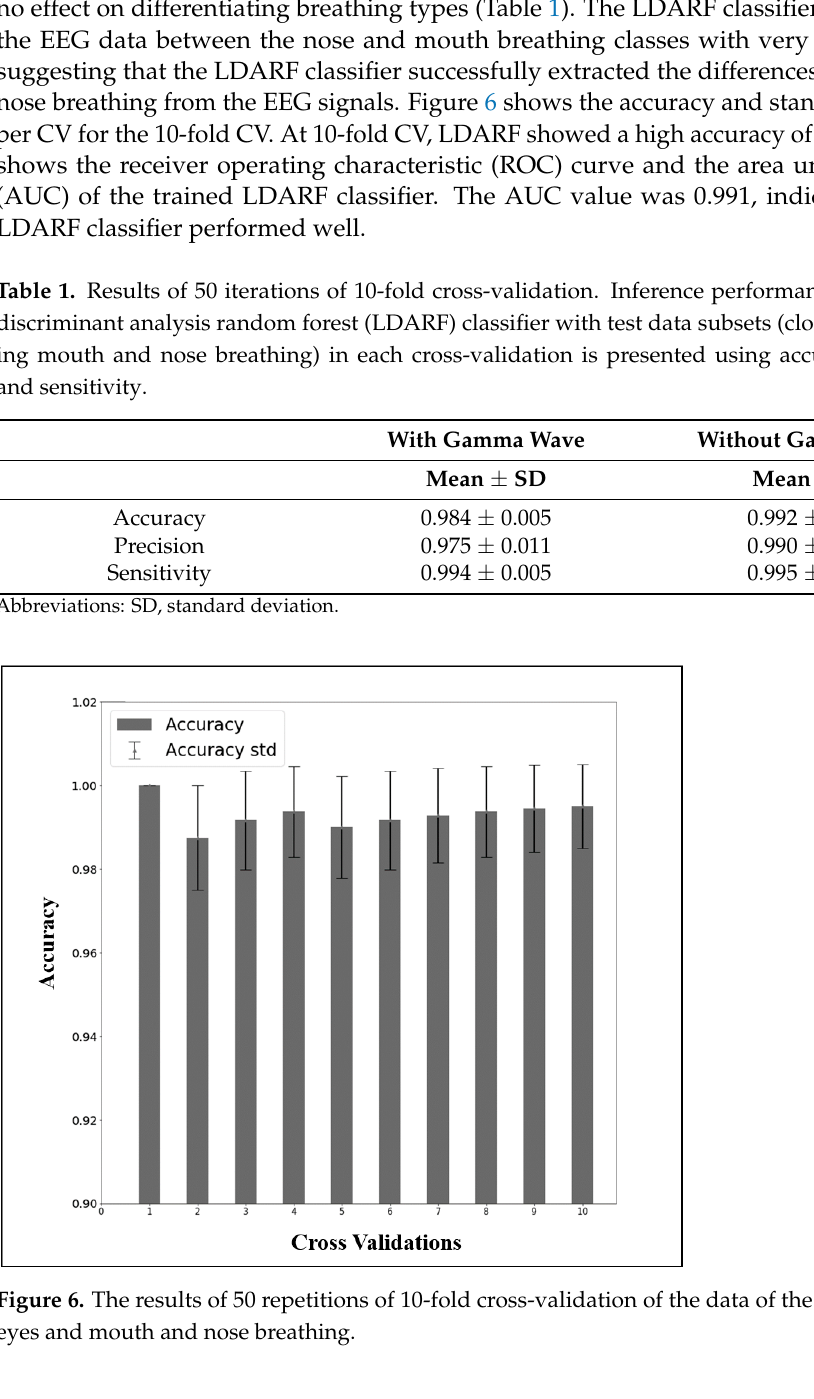
Figure 7. Receiver operating characteristic (ROC) curve and area under the curve (AUC) graph from the condition of rest with closed eyes and mouth and nose breathing, trained with linear discriminant analysis random forest (LDARF) classifier. The AUC of 0.991 confirmed that the LDARF classifier performed well. Table 2 shows the results of tasks with different demands of O 2 supply, which were obtained by applying the previously trained LDARF classifier to the EEG data of those tasks. In Figure 8, the LDARF classifier, which had high accuracy in the closed eyes rest state with mouth and nose breathing, showed a substantially poor performance in mouth breathing with O 2 supply during the rest with open eyes state. The accuracy of the classi- fier dropped from 98% for the rest state with closed eyes to 50% for rest with open and closed eyes and mouth breathing with O 2 supply in the presence of gamma waves. When the LDARF classifier for mouth breathing was trained for O 2 supply situations, the results were significantly less distinguishable, suggesting that the LDARF classifier was affected by the O 2 -related changes in the EEG signals used for distinguishing between mouth and nose breathing. Oxygen was thought to be more adequately supplied at higher levels of